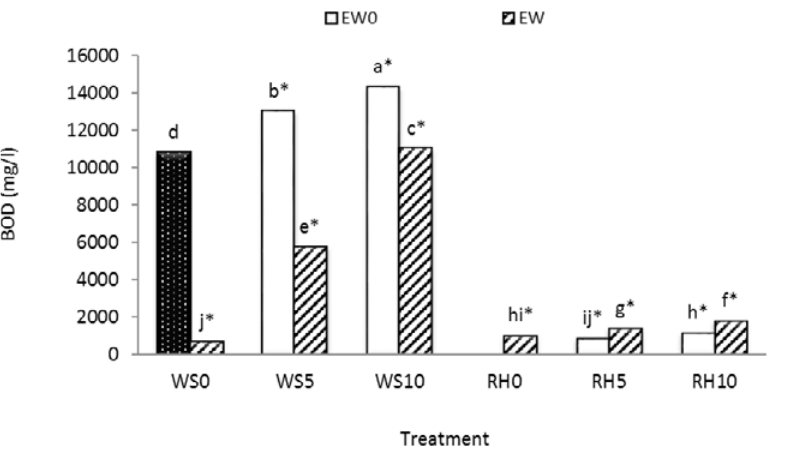
Figure 6. Effects of the treatments on BOD of the wastewater Note: EW0, without vermicomposting; EW, with vermicomposting; WS0, without wheat straw; WS5, 5% v/v wheat straw; WS10, 10% v/v wheat straw; RH0, without rice husk; RH5, 5% v/v rice husk; RH10, 10% v/v rice husk. Means in the same column followed by the same letter are not significantly different according to DMRT at (P≤0.05).